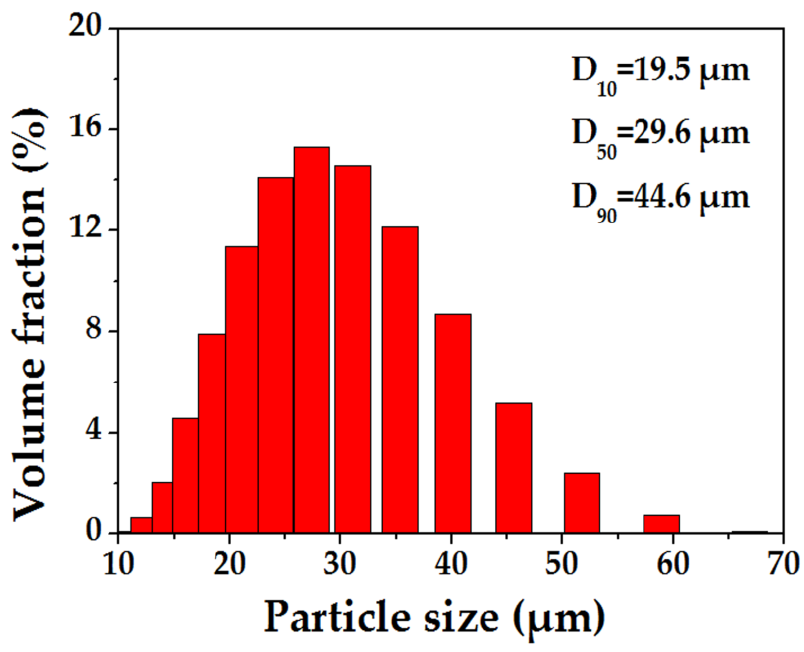
Figure 2. The particle size distribution of WC-17Co powders.